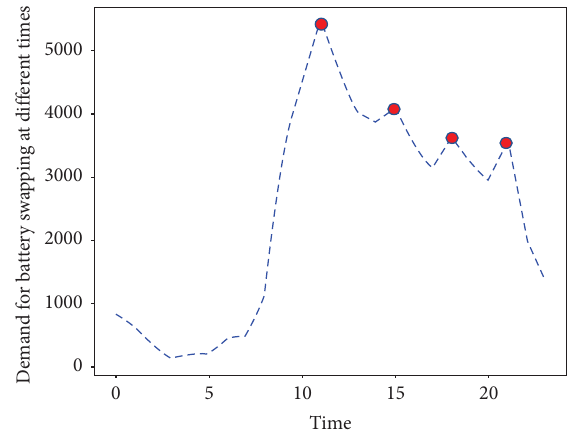
Figure 19: Demand for battery swapping at diferent times.